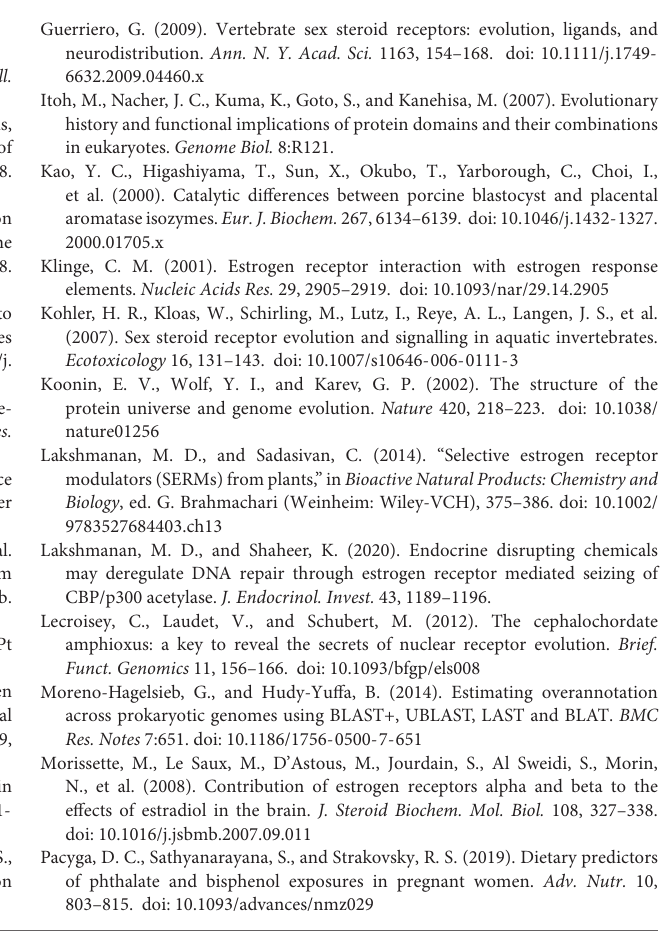
Supplementary Figure 1 | Results for Constraint-based Multiple Alignment Tool. Sequences with no gaps are colored in red or blue. Red indicates highly conserved sequence and blue indicates less conserved sequence. Supplementary Figure 2 | Results for Constraint-based Multiple Alignment Tool for random sequences. Sequences with no gaps are colored in red or blue. Red indicates highly conserved sequence and blue indicates less conserved sequence. Supplementary Figure 3 | Graphical representation of the Constraint-based Multiple Alignment for random sequences. Sequences with no gaps are colored in red or blue. Red indicates highly conserved sequence and blue indicates less conserved sequence. Line indicates gaps. (A) Six random sequences. (B) Four selected random sequences. Supplementary Table 1 | Sequence ID and their Function for the random sequences selected for COBALT